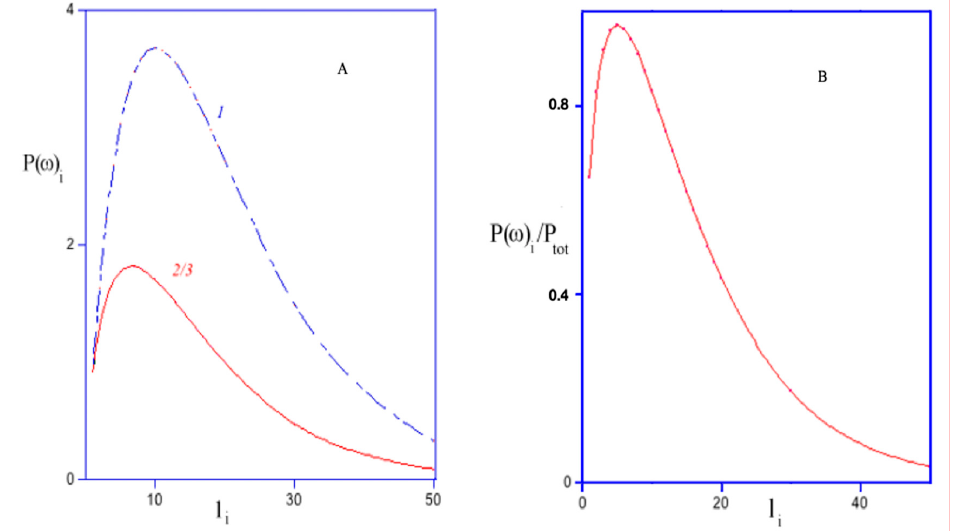
Figure 4. ( A ). Binding probability, P ( Ω ) i , in arbitrary units, vs. the number of polymer units in the Figure 4. ( A ). Binding probability, P( Ω ) i , in arbitrary units, vs. the number of polymer units in the main chain, l i , for k i main chain, l i , for k i terms equal to 2/3, red, and 1.0, blue, at 25.0 ◦ . Data were calculated for PEO terms equal to 2/3, red, and 1.0, blue, at 25.0°. Data were calculated for PEO binding onto SiO 2 . The number of segments in binding onto SiO 2 . The number of segments in PEO chain is 50; the NP ’s diameter is 200 nm. ( B ). PEO chain is 50; the NP ’s diameter is 200 nm. ( B ). Normalized plot of P( Ω ) i /P tot vs. l i , calculated assuming k i to be propor- Normalized plot of P ( Ω ) i / P tot vs. l i , calculated assuming k i to be proportional to tional to √ l i . The behavior conforms to common knowledge on the binding efficiency of small-medium length polymers. See the text for more details. conforms to common knowledge on the binding efficiency of small-medium length polymers. See the text for more